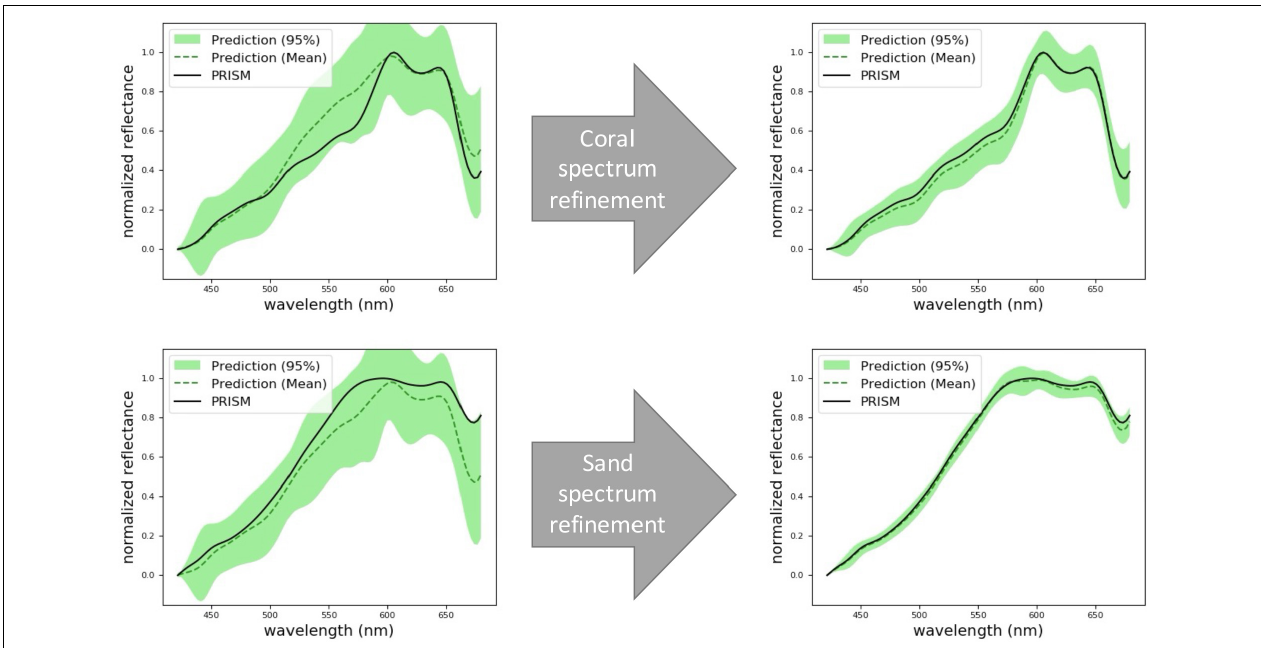
FIGURE 4 | Prediction of coral (top row) and sand (bottom row) spectra at two locations that are never actually sampled. Here we use PRISM as the ground truth. At first, the model’s predictions have a low accuracy and a high uncertainty (left column) . After collecting more samples, the model refines its spectral predictions (right column)